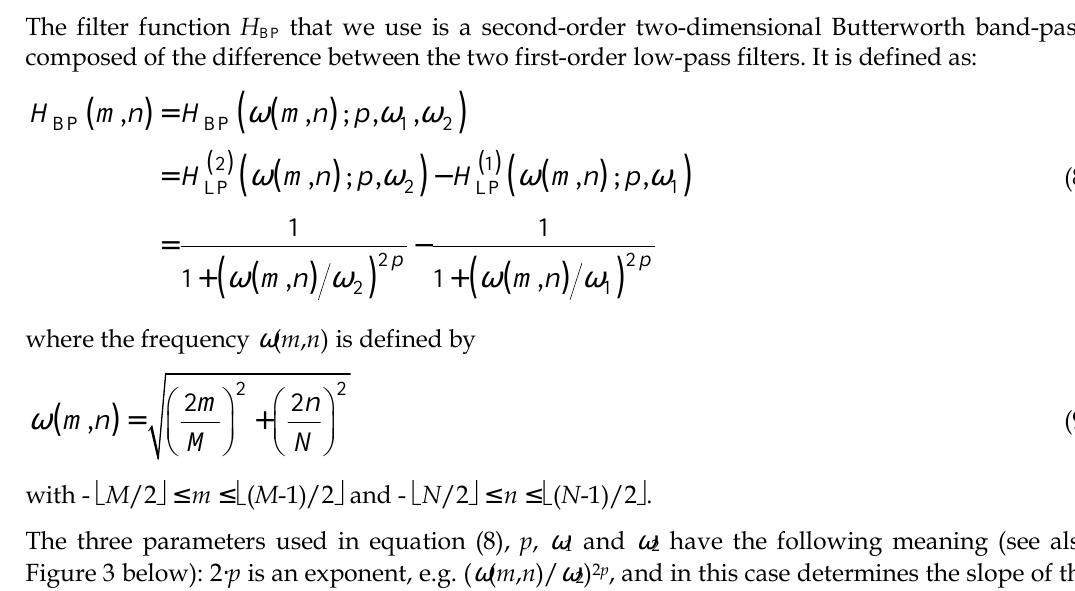
Figure 3 below): 2 (cid:215) p is an exponent, e.g. ( w ( m , n )/ w 2 ) 2 p , and in this case determines the slope of